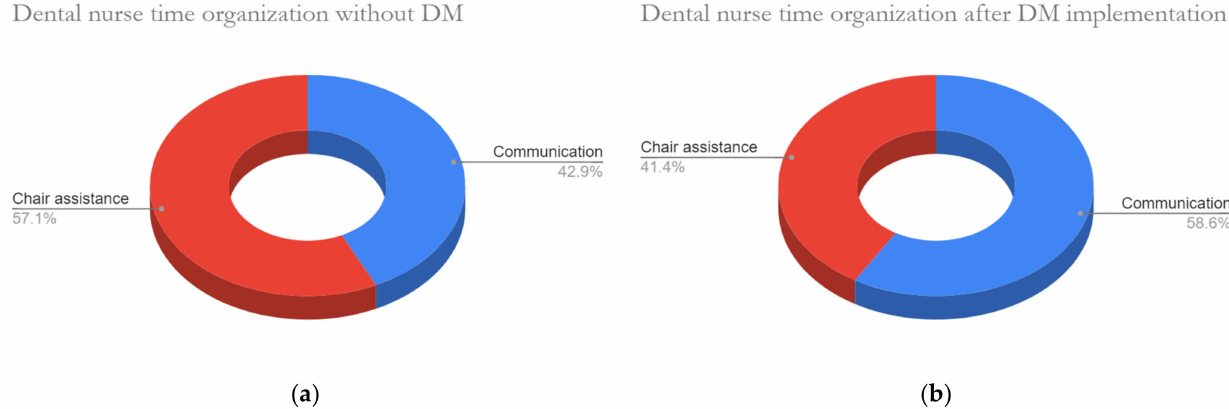
Figure 5. The proportion of direct chair assistance from the nurse/dental assistant was reduced in comparison to the amount of communication after DM implementation. Additional communication with the patient in the dental office was brought in by DM, as it often prevented the patient from moving to the next aligner when a problem was observed. ( a ) Prior to DM implementation, dental nurses mainly communicated with patients via email and SMS, mostly regarding appointment times and dates; ( b ) DM has shifted the amount of necessary communication that can be semiautomated later by